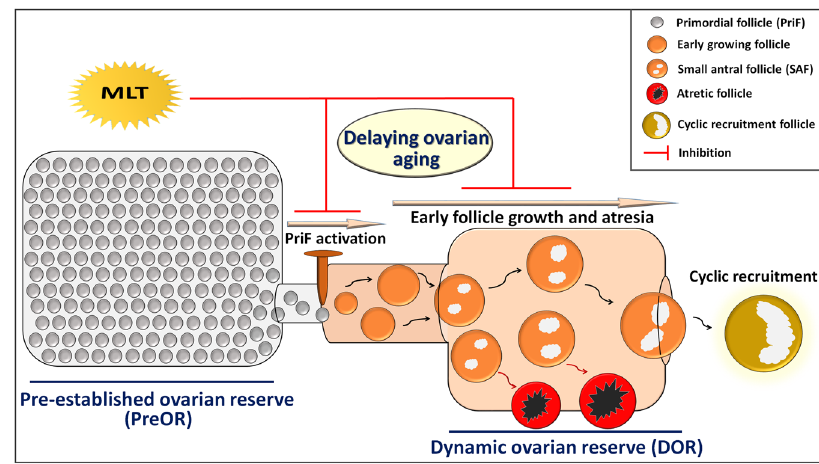
Fig. 7 A proposed model to explain how MLT delays ovarian aging. The depletion of ovarian follicle reserve is the direct cause of ovarian aging. MLT slows down the exhaustion of follicle reserve by inhibiting the activation, growth, and atresia of follicles in PreOR and DOR, thus delaying ovarian